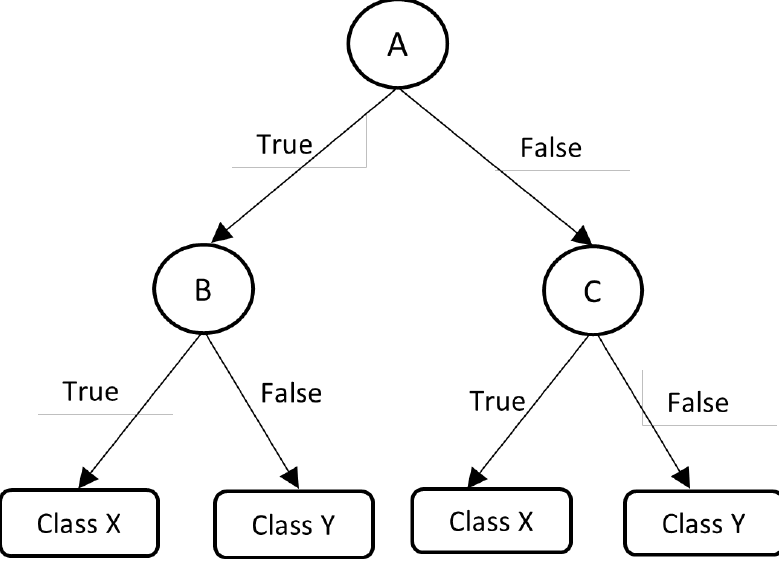
Figure 3. An illustration of the Decision